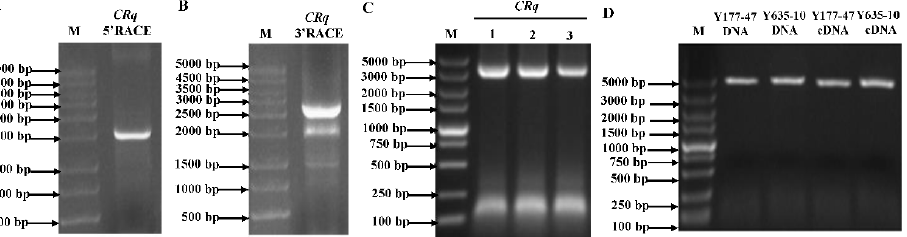
Figure 4. The CRq gene by RACE cloning. ( A ) The length of the RACE at the 5′ end of CRq . ( B )The length of the RACE at the 5′ end of CRq . ( C ) Full length of CRq gene. ( D ) Amplification of CRq genome sequence and gene coding region sequence in clubroot-susceptible Y177-47 and clubroot-resistant Y635-10. Sequence analysis showed that the candidate genes of Y177-47 and Y635-10 were 4031 bp and 3959 bp, respectively, and contained 3 exons and 2 introns. The CDS lengths of candidate genes Y177-47 and Y635-10 were 3747 bp and 3675 bp, respectively.